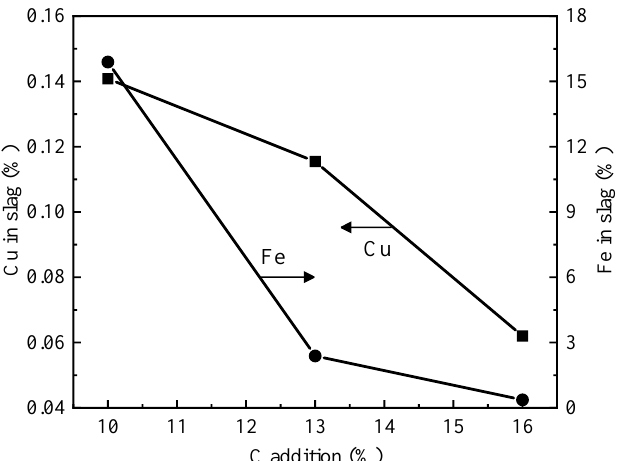
Figure 6. Experimentally determined copper and iron contents in the reduced slag at 1400 °C with 5% CaO addition.